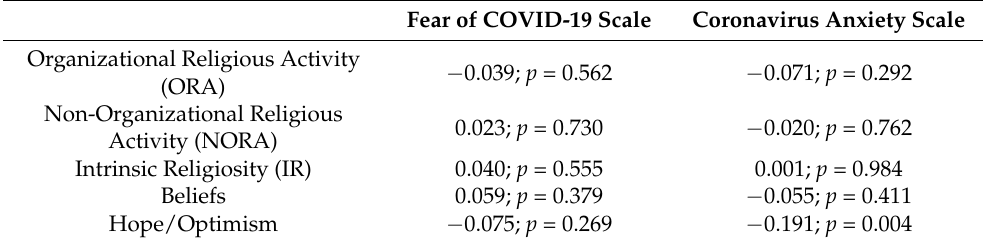
Table 3. Spearman correlation between outcomes (Fear of COVID-19 Scale and Coronavirus Anxiety Scale) and the subscales (ORA, NORA, IR, Beliefs and Hope/Optimism).